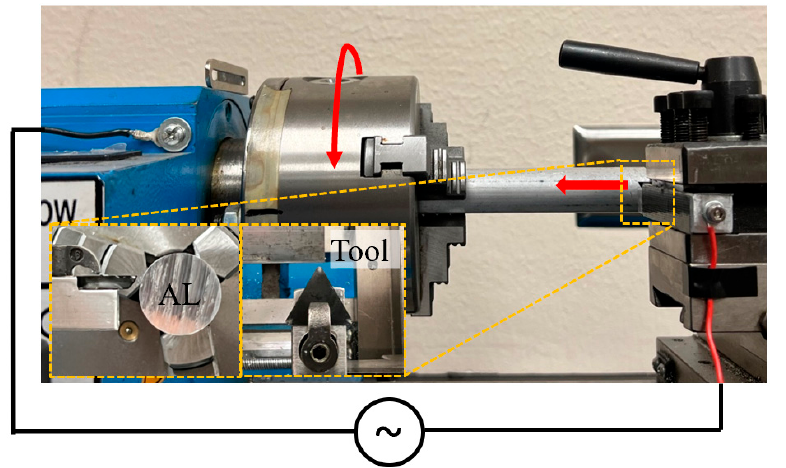
Figure 7. Turning machining experiment setup.